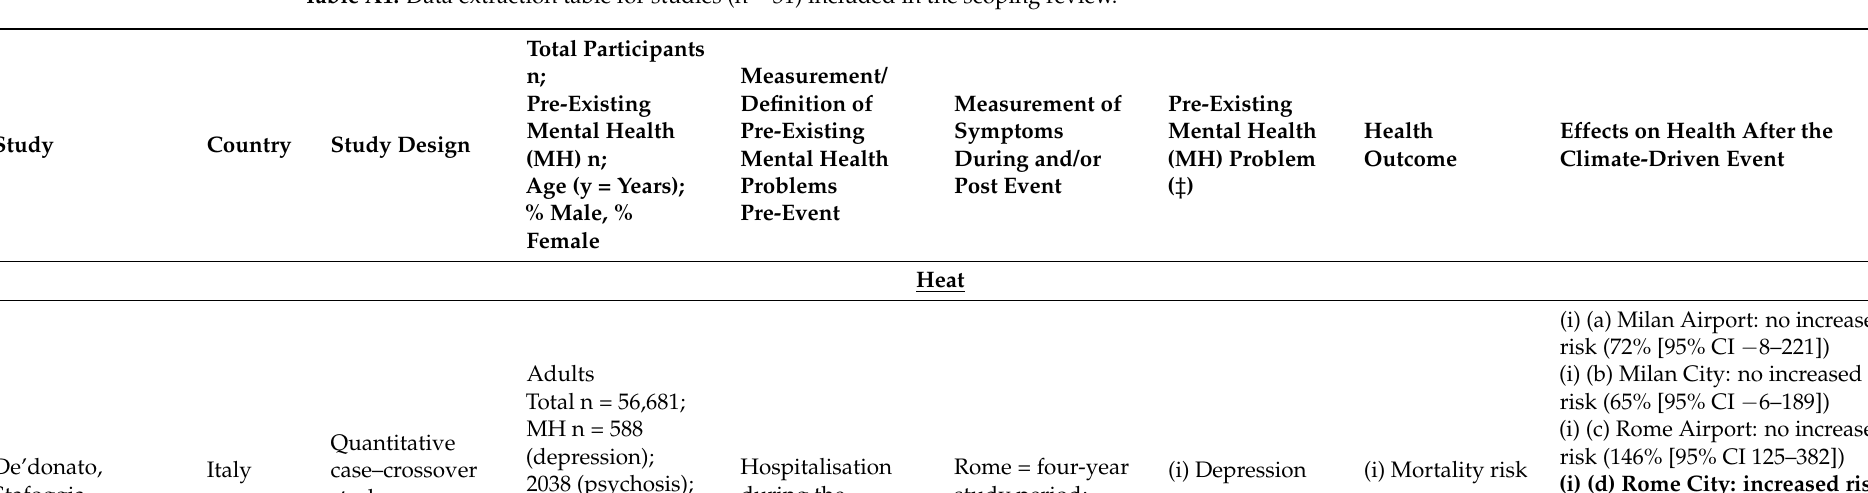
Table A1. Data extraction table for studies (n = 31) included in the scoping